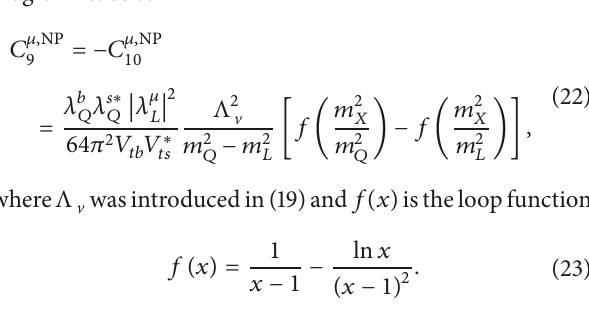
Figure 3: Contours for constant 𝐶 (dashed black) in the (𝑔 푋 ,𝑚 푍 󸀠 ) plane. For the ratio 𝐶 full 1-loop results are shown via the black lines, while the dotted grey lines give the values using the tree-level approximation. Red lines indicate the preferred values for 𝐶 global fits and cosmological observations, respectively. Figure taken from